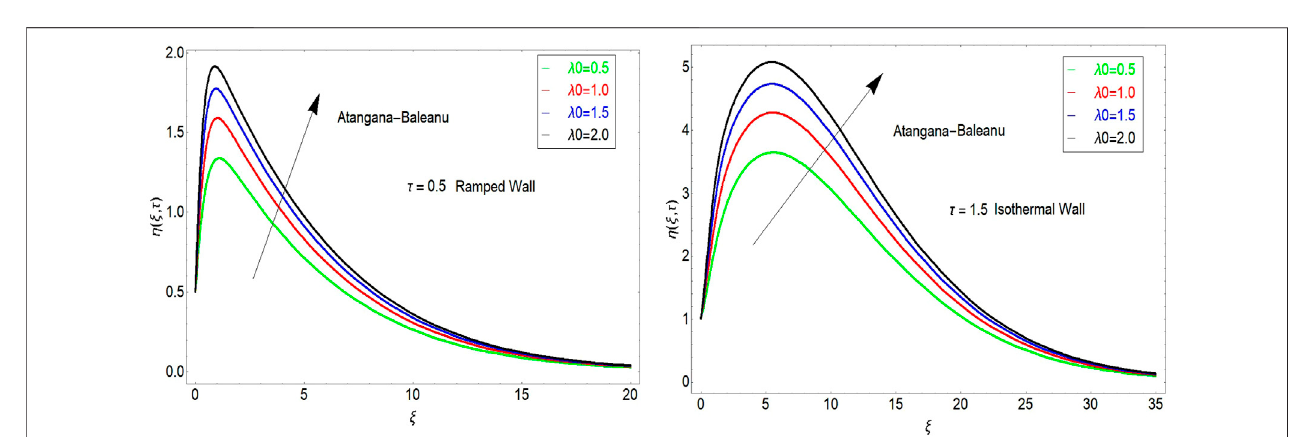
FIGURE 6 | In fl uence of on velocity for constant and ramped temperature.